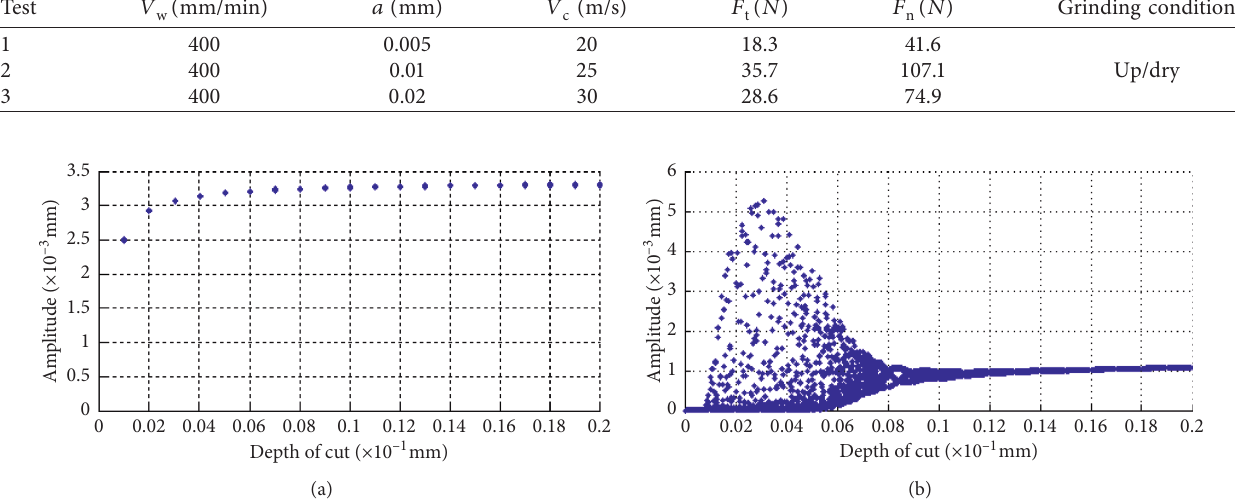
Figure 4: Bifurcation diagram of the grinding wheel displacement as a function of the depth of cut at the cutting speed of 20m/s. (a) Tangential direction. (b) Normal direction.